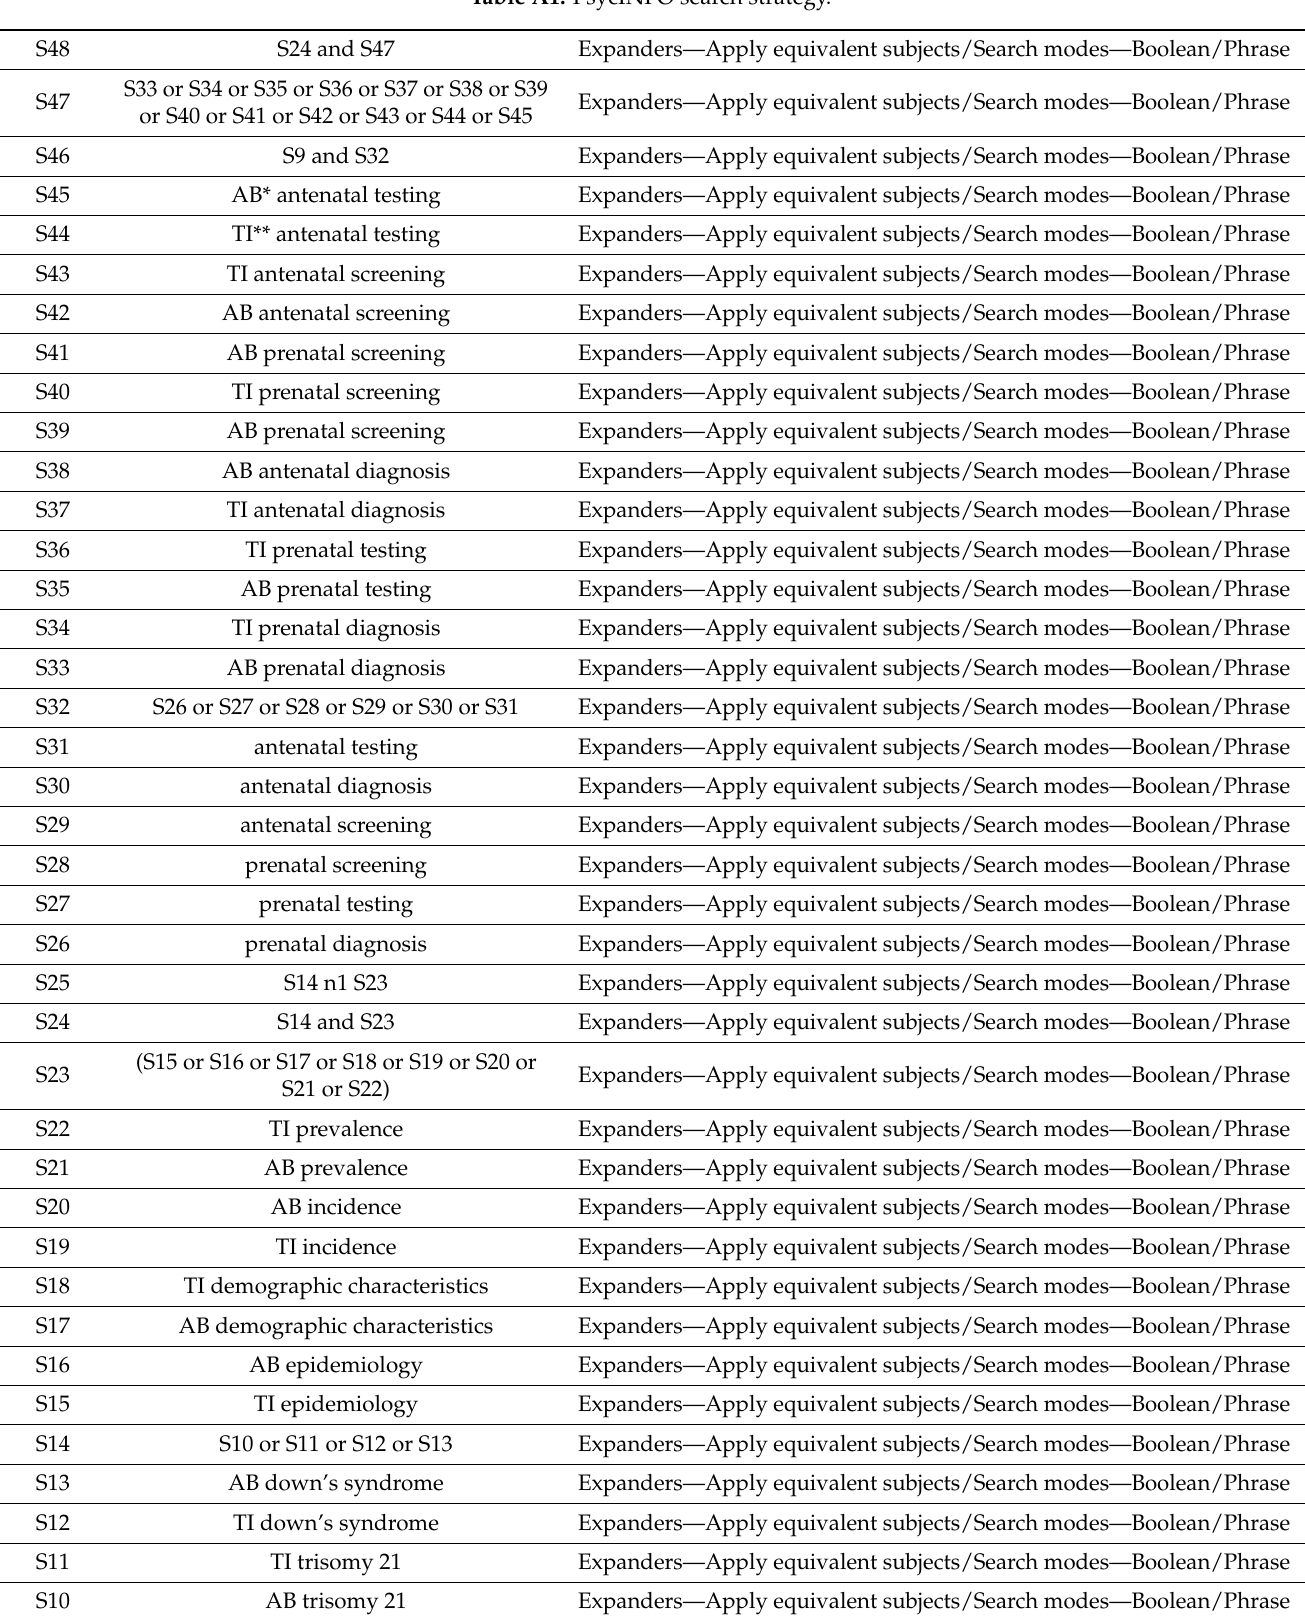
Table A1. PsycINFO search